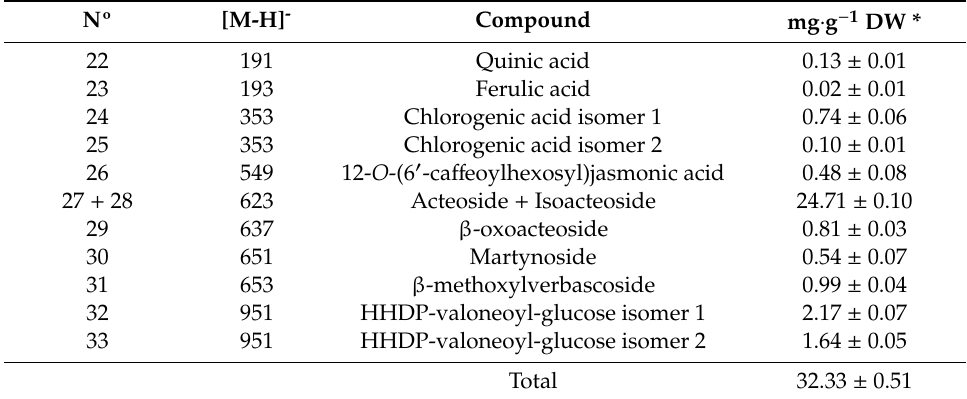
Table 3. Quantitative analysis of phenolic acids from Colebrookea oppositifolia methanol extract.